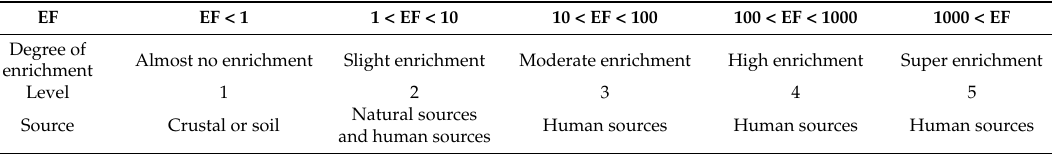
Table 1. Relationships between enrichment factor (EF) and enrichment degree of the studied